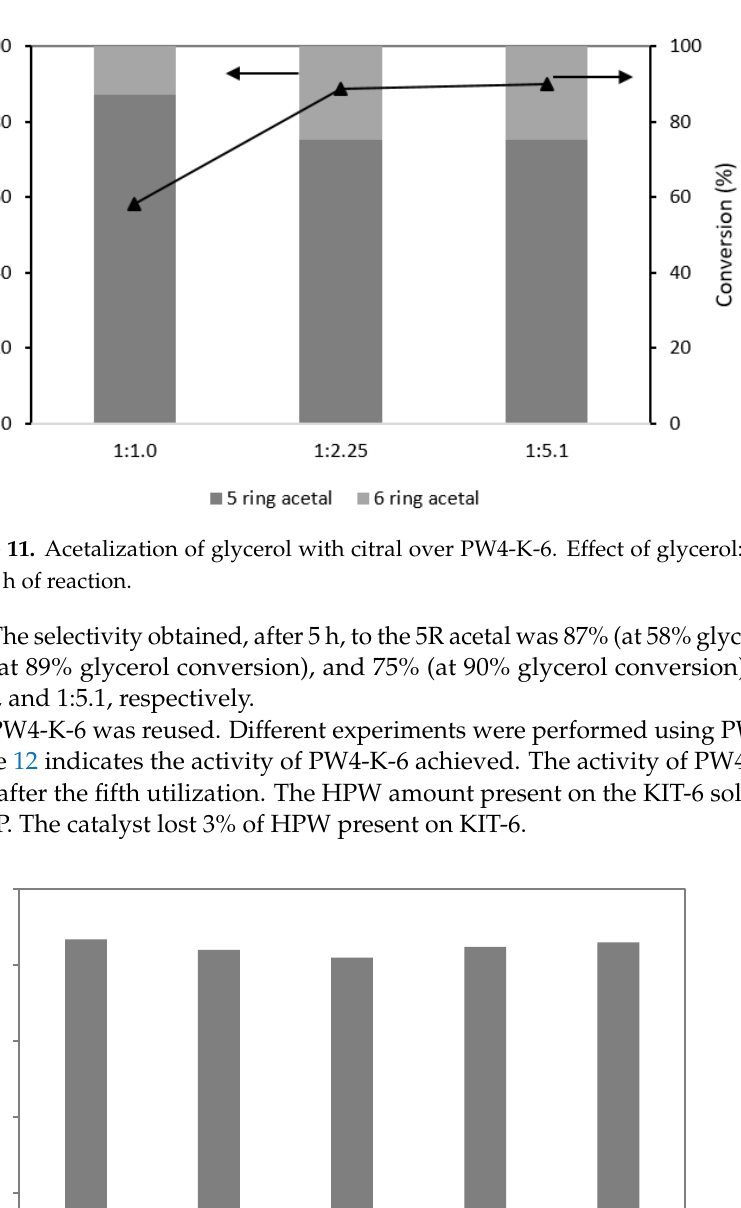
Table 3. Conversion of glycerol and selectivity to 5R acetal and 6R acetal.